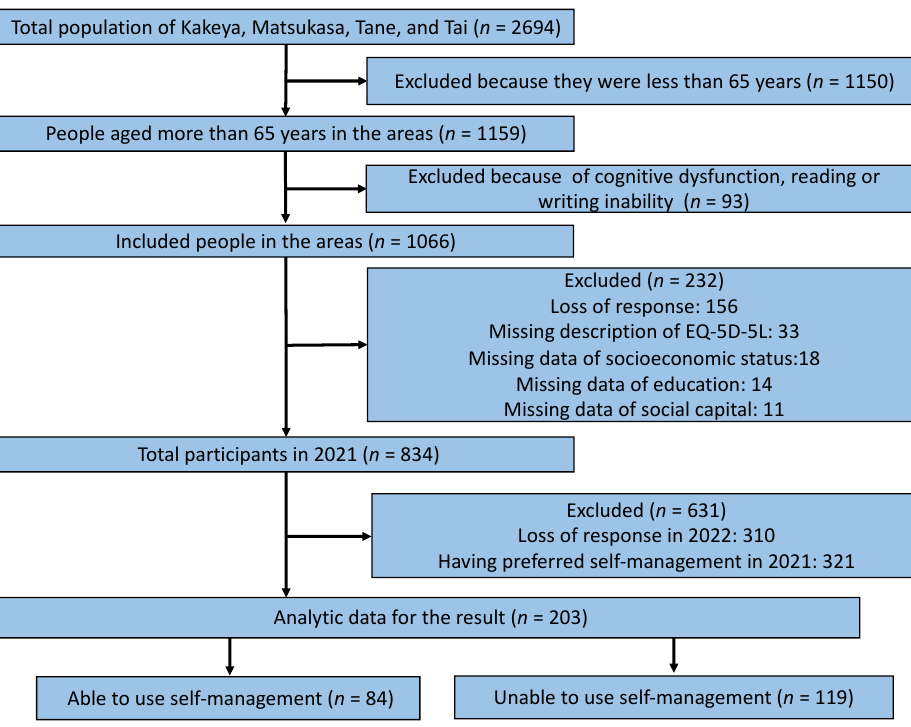
Figure 1. Flowchart of participant selection. Table 1. Demographic data of participants in the exposure and control groups and the significance level of the comparison between the two groups.